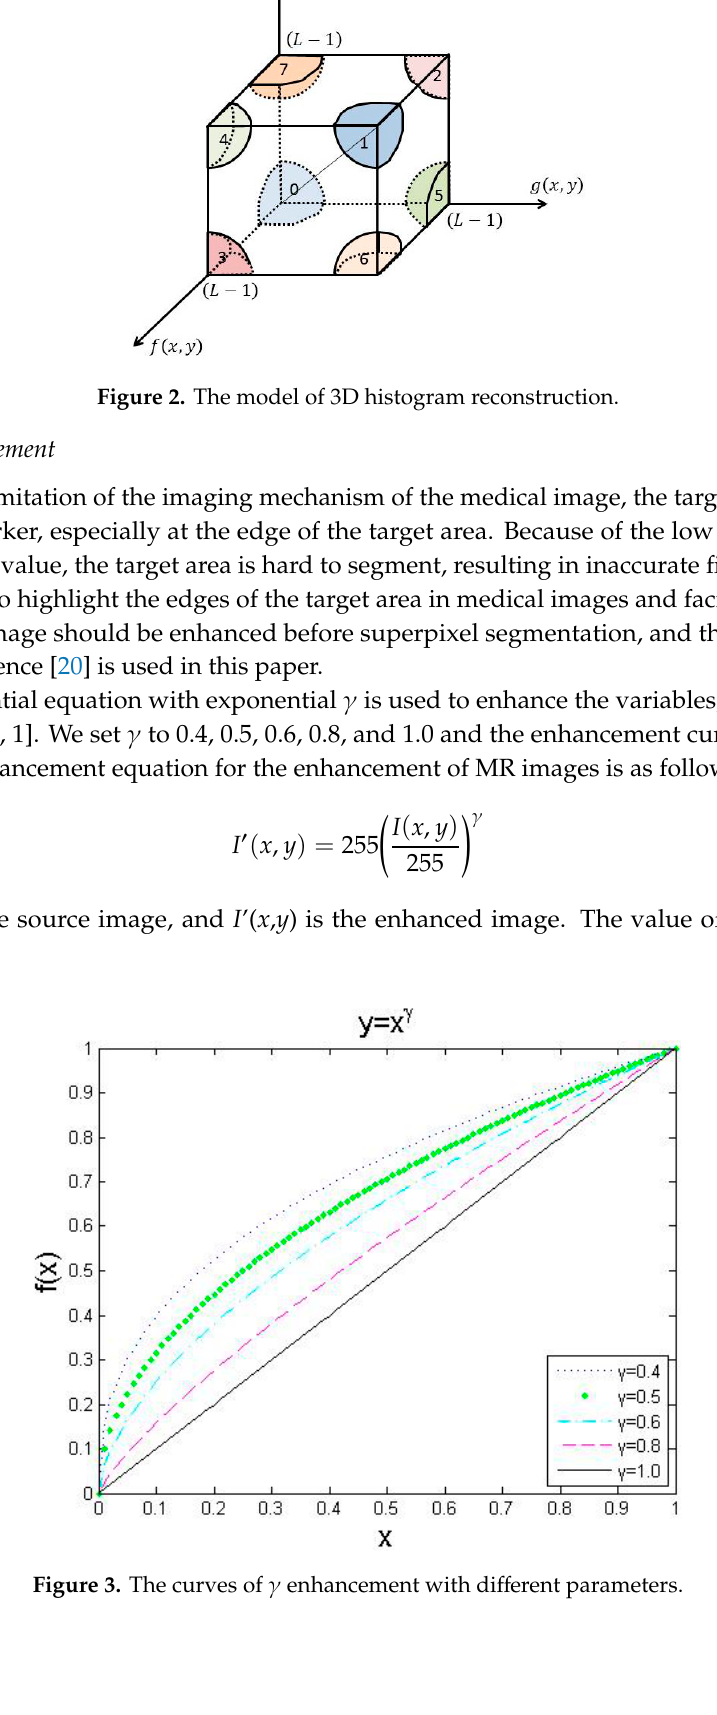
Figure 3. The curves of